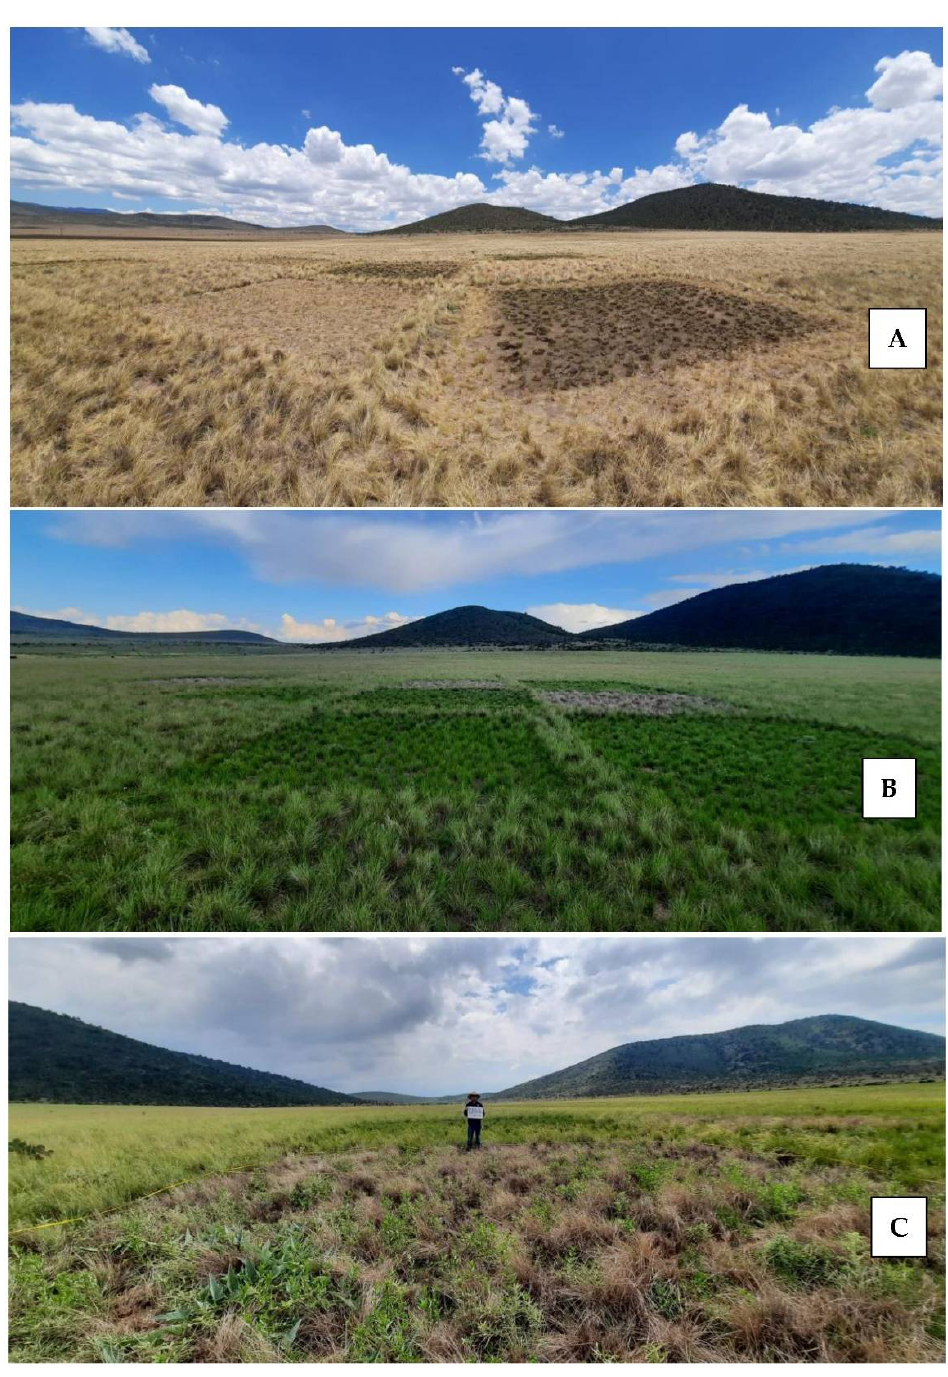
Figure 3. Grassland of Mexican needlegrass ( Amelichloa clandestina ): ( A ) application of burning and clipping treatments in foreground of the photo; ( B ) response of the grass after application of treatments and during the rainy season in the following summer; ( C ) plot where the herbicide glyphosate was applied, in which a greater richness of species can be observed.